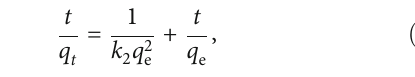
Figure 7: Impact of interaction time on the removal of MO dye using AlgN and AlgN-CTAB ( adsorbent mass = 0 : 1 g , ½ MO (cid:2) mgL − 1 , pH = 5 , and T = 27 ° C